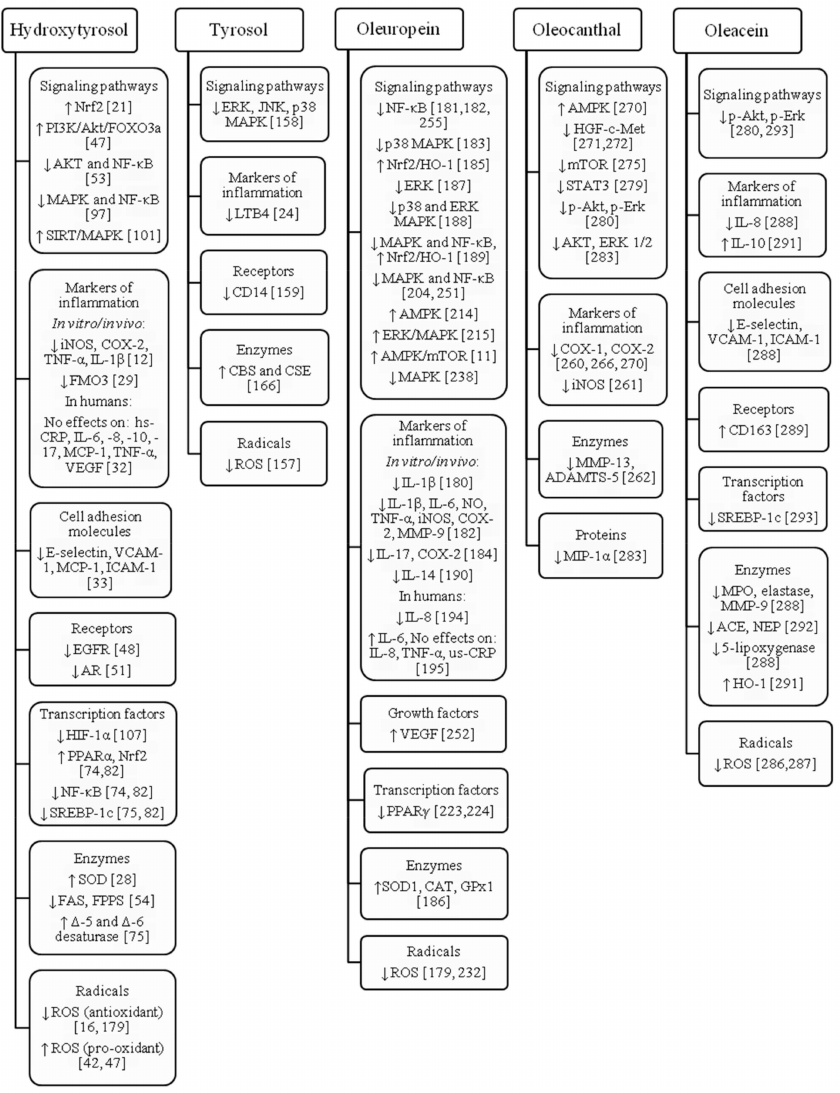
Figure 1. Signaling pathways and targeted molecules a ff ected by hydroxytyrosol, tyrosol, oleuropein, oleocanthal and oleacein. ACE: angiotensin converting enzyme; ADAMTS: a disintegrin and metalloproteinase with thrombospondin motifs (aggrecanase); Akt: Protein kinase B; AMPK: adenosine monophosphate-activated protein kinase; AR: androgen receptor; CAT: catalase; CBS: cystathionine β -synthase; CD: cluster of di ff erentiation; COX: cyclooxygenase; CSE: cystathionine γ -lyase; EGFR: epidermal growth factor receptor; Erk: extracellular regulated mitogen activated protein kinase; FAS: fatty acid synthase; FMO3: flavin containing monooxygenase 3; FPPS: farnesyl diphosphate synthase; GPx1: glutathione peroxidase 1; HGF / c-Met: hepatocyte growth factor / tyrosine-protein kinase Met; HIF-1 α : hypoxia-inducible factor-1; HO-1: hem oxygenase 1; hs-CRP: high-sensitive C-reactive protein; ICAM-1: intracellular cell adhesion molecule 1; IL: interleukin; iNOS: inducible nitric oxide syntase; JNK: c-Jun N-terminal kinase; LTB4: leukotriene B4; MAPK: mitogen activated protein kinase; MCP-1: monocyte chemoattractant protein 1; MIP-1 α : macrophage inflammatory protein 1 α ; MMP: matrix metalloproteinase; MPO: myeloperoxidase; mTOR: mammalian target of rapamycin; NEP: neutral endopeptidase; NF- κ B: nuclear factor kappa B; NO: nitrogen oxide; Nrf2: nuclear factor E2-related factor 2; p-Akt: phosphorylated Akt; p-Erk: phosphorylated Erk; PI3K / Akt / FOXO3a: phosphoinositide 3-kinase / Akt / Forkhead box O3; PPAR: peroxisome proliferator-activated receptor; ROS: reactive oxygen species; SIRT: sirtuin; SOD: superoxide dismutase; SREBP-1c: sterol regulatory element binding protein 1c; STAT3: signal transducer and activator of transcription 3; TNF- α : tumor necrosis factor- α ; VCAM-1: vascular cell adhesion molecule 1; VEGF: vascular endothelial growth